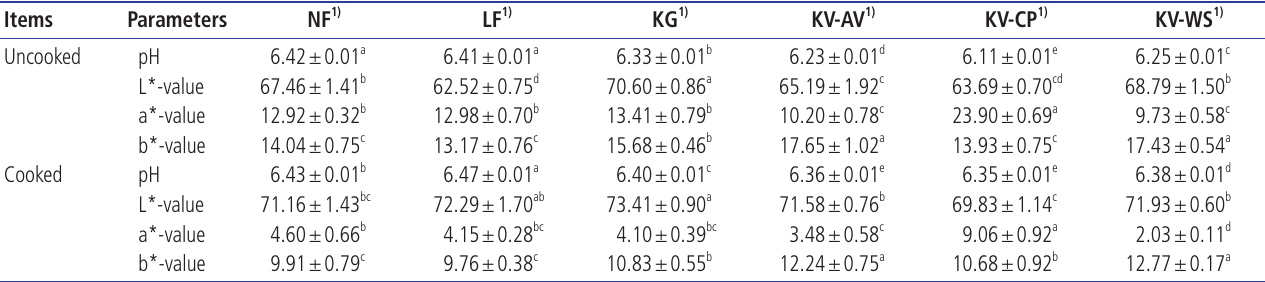
Table 4. The pH and color parameters of frankfurter sausages